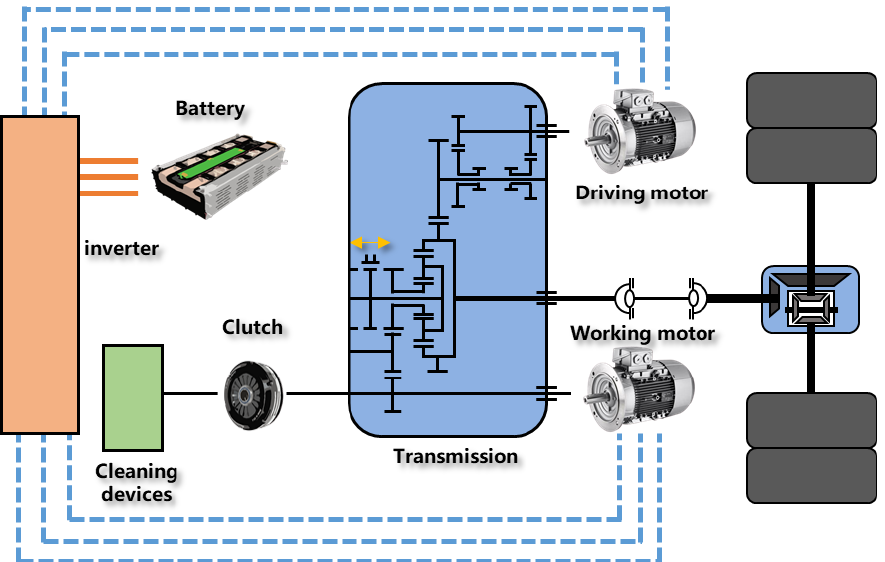
Figure 1. Research object: the sanitation vehicle: ( a ) front view ( b ) side view.